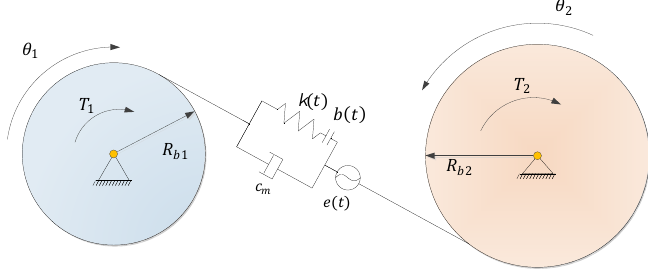
Figure 1. Traditional SDOF dynamic model for a gear system.